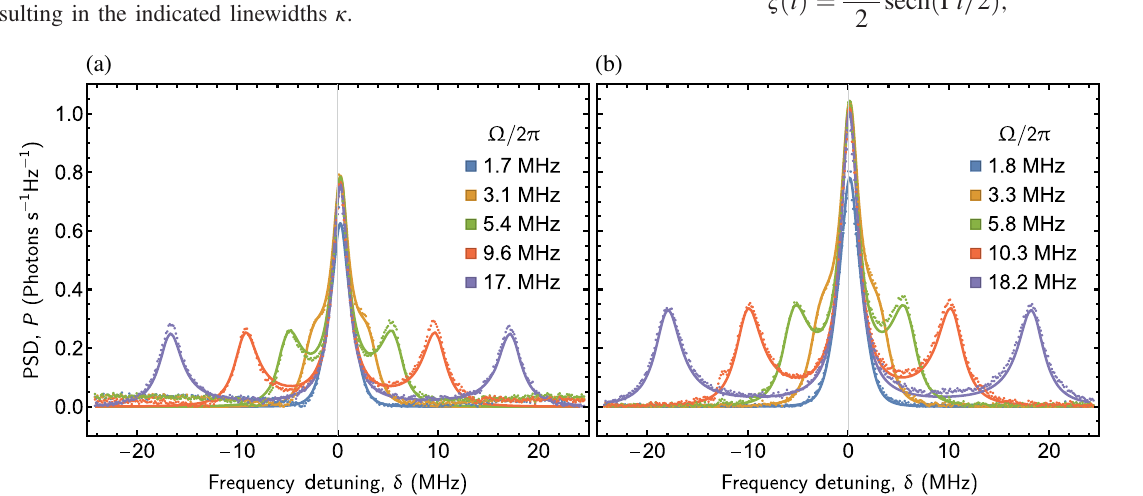
FIG. 8. Measured power spectral density (PSD) P of the inelastic scattering of a coherent tone resonant with (a) the source qubit and (b) the gate qubit converter mode for the indicated drive rates Ω . All datasets are scaled with respect to the gate qubit fitted amplitude P 0 ; see the text. Solid lines are joined fits to all datasets with a single set of fitting parameters. The drive rates Ω are fitted ;G independently for each